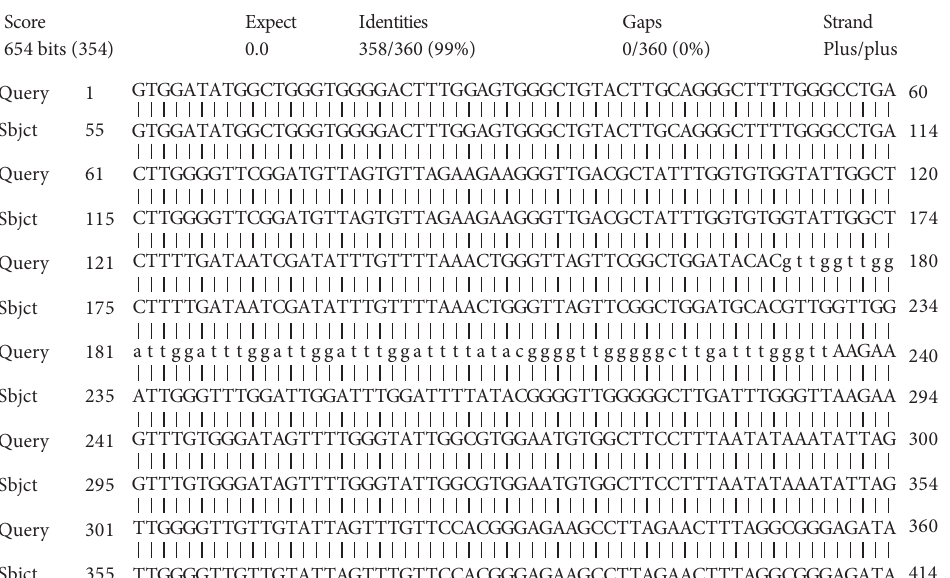
Figure 3: Multiple alignment of Leishmania donovani kinatoplast minicircle DNA sequence (query) with the sequences available in NCBI (subject). Table 2: Cutaneous leishmaniasis incidence in three selected MOH areas. MOH